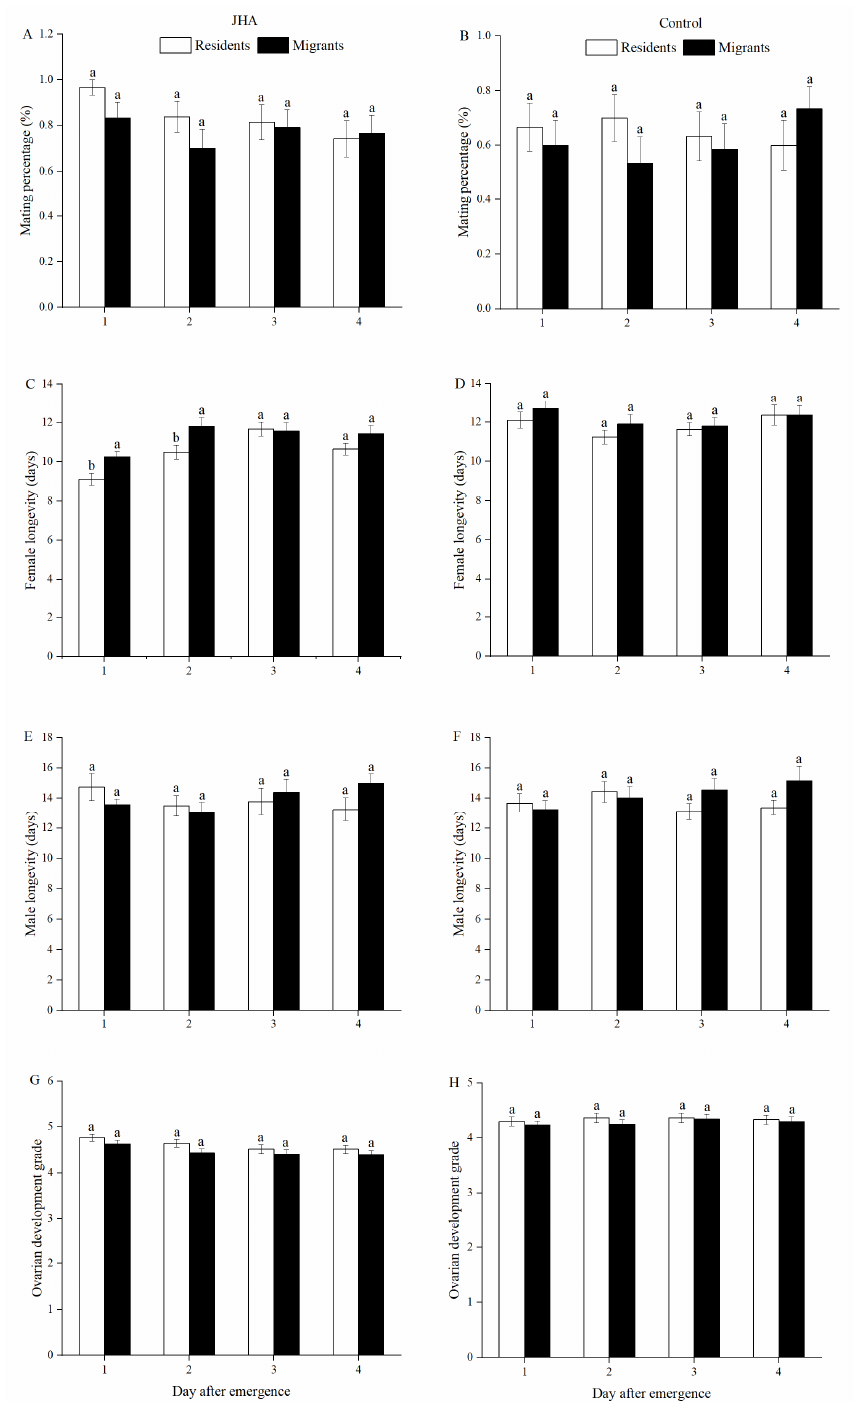
Figure 2. Mating percentage ( A : JHA, B : Control), female longevity ( C : JHA, D : Control), male longevity ( E : JHA, F : Control) and ovarian development grade ( G : JHA, H : Control) of M. separata between residents and migrants exposed to JHA at various ages. Different lowercase letters above group bars represent significant differences between residents and migrants at the 5% level by Tukey’s HSD test. Sample sizes for each JHA treatment (left to right), residents: 30, 31, 26 and 29 pairs; migrants: 30, 30, 29 and 30 pairs. Sample sizes for each control treatment (left to right), residents: 30, 30, 30 and 30 pairs; migrants: 30, 28, 29, and 30 pairs.